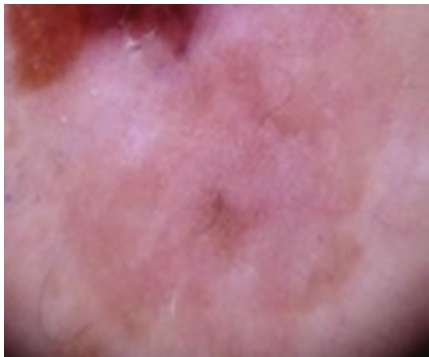
Figure 7: Case 1. Closeup view of lower third of the lesion with patches of pigment globules and glomerular vessels in clustered and linear